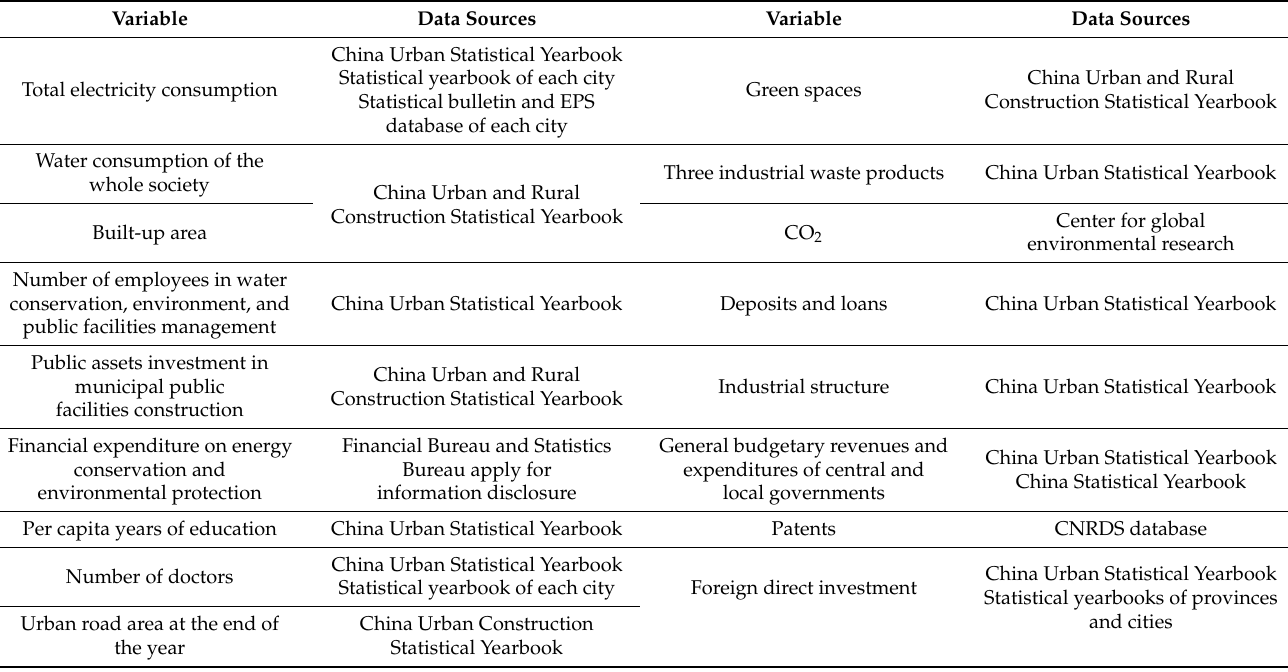
Table 3. Sources of